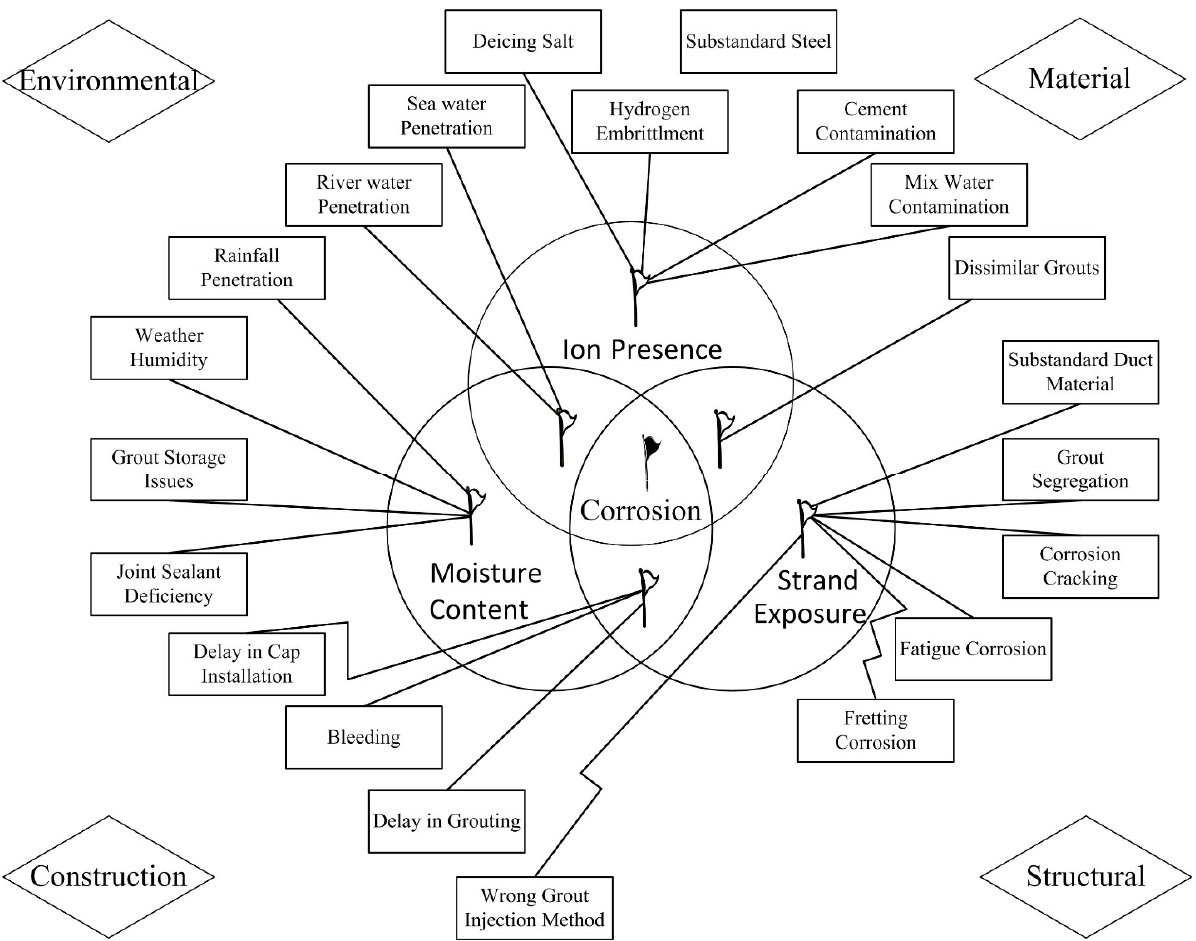
Figure 2. Classification of factors involved in corrosion of external post-tensioning system.